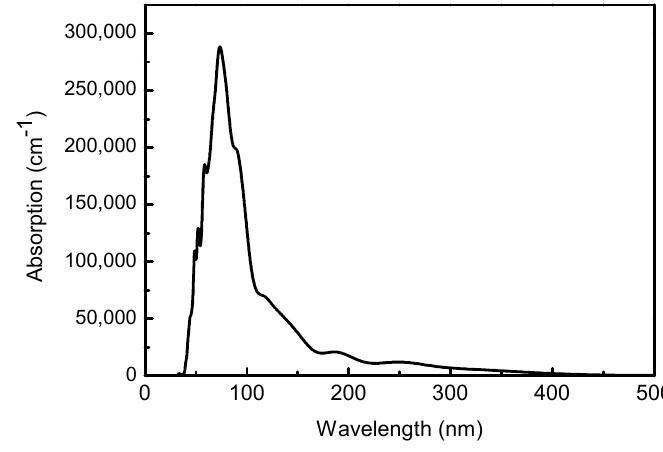
Figure 8. Absorption of pure ZnO.